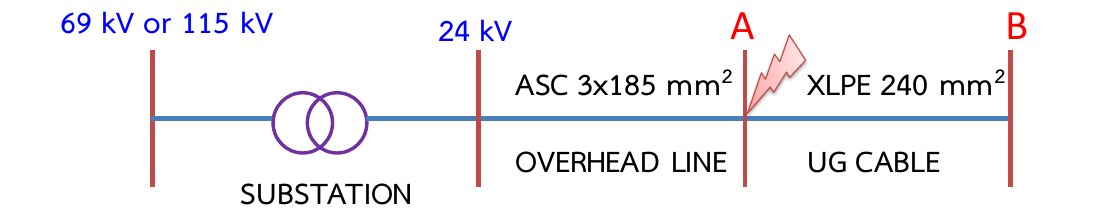
Figure 27. System not protected by lightning arrester.